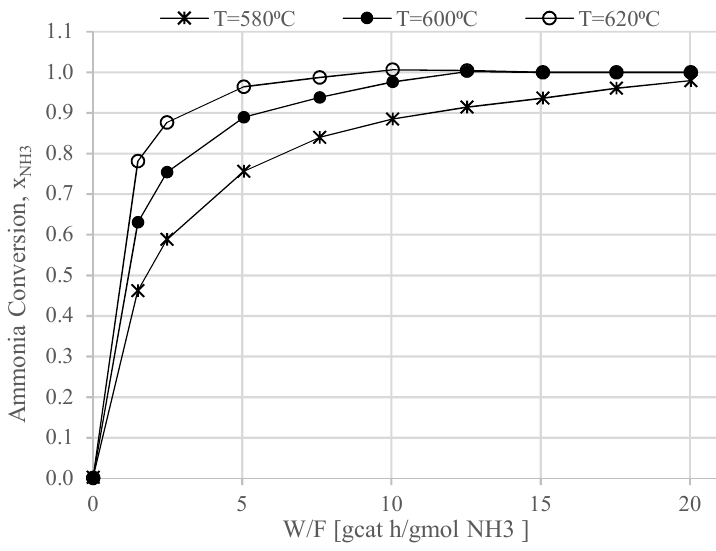
Figure 2. Effect of temperature on ammonia decomposition at different contact time i.e., catalyst weight/volume flow rates (W/F) using Ni–Pt/Al 2 O 3 catalyst (Adapted from [34] with permission from Elsevier).